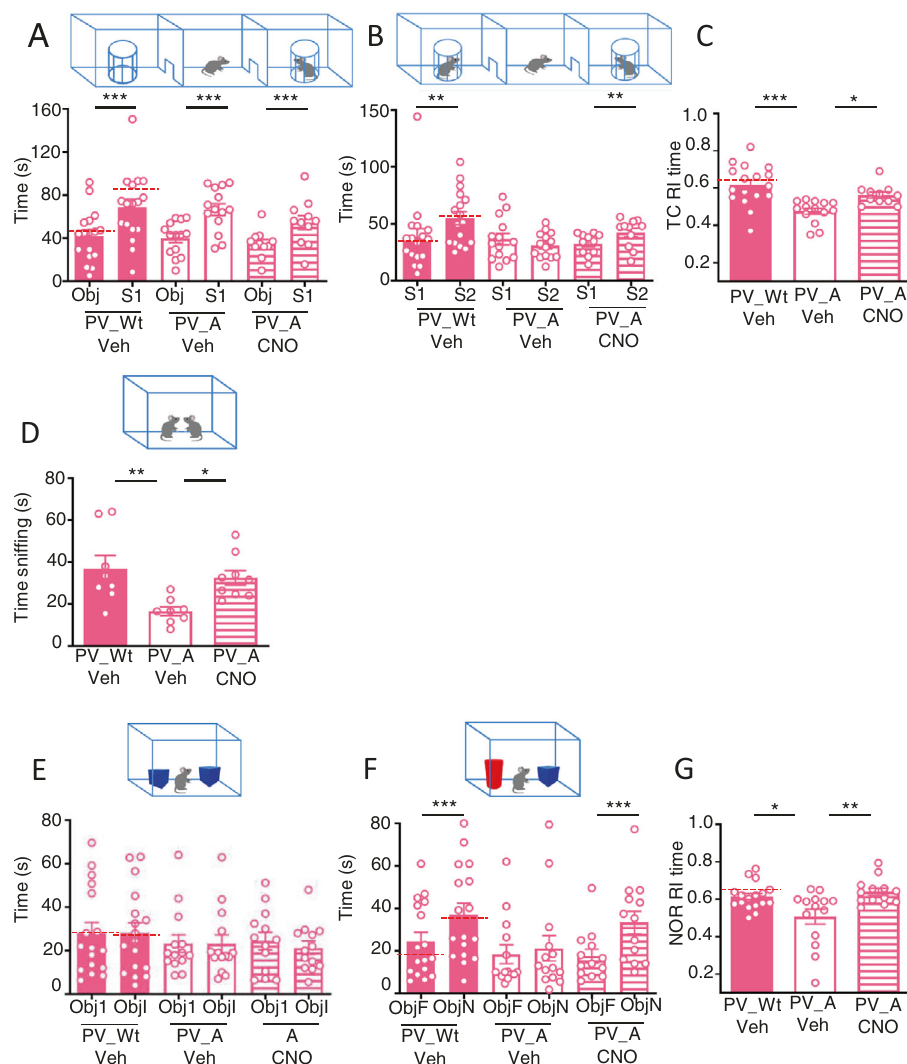
Fig. 2 Chemogenetic activation of inhibitory PV-IN in Ambra1 + / − females normalizes autistic-like behaviors. A Histogram report mean time spent exploring the object (Obj) and the conspeci fi c stranger (S1) during the sociability phase of the TC test. All mice explore more the conspeci fi c stranger than the object (PV_Wt/Veh: Obj vs S1: t (16) = 7.116, p = 0.0001; PV_A/Veh: Obj vs S1: t (13) = 7.714, p = 0.0001; PV_A/CNO: Obj vs S1: t (10) = 5.507, p = 0.0003; Dotted-line indicate mean values detected in PV_Wt/CNO control mice infused with vehicle instead of DREADDs. B Histogram report mean-time spent exploring the familiar female (S1) and the novel female (S2) during the social novelty phase of the TC test. Only PV_A/Veh females show impairment in recognition of the social novelty as they spent equal amounts of time snif fi ng S1 and S2. (PV_Wt/Veh: S1 vs S2: W = 119, p = 0.0032; PV_A/Veh: S1 vs S2: t (13) = 1.740, p = 0.1; PV_A/CNO: S1 vs S2: W = 55, p = 0.002). Dotted-line indicate mean values detected in PV_Wt/CNO control mice infused with vehicle instead of DREADDs. C Histogram reporting the mean recognition index (RI) calculated during the social novelty phase of TC. Social novelty impairments in A/Veh females are rescued in A/CNO females. TC social novelty phase: PV_Wt/Veh ( N = 17), PV_A/Veh, ( N = 14), PV_A/CNO ( N = 11), F (2,39) = 11.26 p = 0.0001; PV_Wt/Veh vs PV_A/ Veh, p = 0.00086; PV_A/Veh vs PV_A/CNO, p = 0.037. Dotted-line indicate mean values detected in PV_Wt/CNO control mice infused with vehicle instead of DREADDs. D Histogram reports mean time spent exploring an unknown conspeci fi c during the social interaction in pair test (SIP). Social interaction impairments of PV_A/Veh females in SIP test are rescued in PV_A/CNO females (SIP: PV_Wt/Veh ( N = 8), PV_A/Veh ( N = 8), PV_A/CNO ( N = 9), F (2,22) = 6.186, p = 0.007; PV_Wt/Veh vs PV_A/Veh, p = 0.009; PV_A/Veh vs PV_A/CNO, p = 0.04). E Histogram report mean time spent exploring the two identical objects (Object 1 (Obj1) and Identical Object (Obj I)) during the object exploration phase of the NOR test by PV_Wt/Veh females and PV_A females injected with Veh or CNO. Data indicate that regardless of genotype and treatment all mice similarly explore the identical objects (PV_Wt/Veh: Obj1 vs ObjI: W = 7, p = 0.88; PV_A/Veh: Obj1 vs ObjI: W = -38, p = 0.24; PV_A/CNO: Obj1 vs ObjI: t (12) = 1.102, p = 0.29). Dotted-line indicate mean values detected in PV_Wt/CNO control mice infused with vehicle instead of DREADDs. F Histogram report mean time spent exploring the familiar object (ObjF) and the novel object (Obj N) during the test phase of the NOR by PV_Wt/Veh females and PV_A females injected with Veh or CNO. Data indicate that recognition impairments of the novel object in A/Veh females are rescued in A/CNO females. (ObjF vs ObjN: PV_Wt/Veh: t (16) = 7.06, p = 0.0001; PV_A/Veh: W = -29, p = 0.38; PV_A/CNO: W = -91, p = 0.0002). Dotted-line indicate mean values detected in PV_Wt/CNO control mice infused with vehicle instead of DREADDs. G Histogram reporting the mean recognition index (RI) calculated during the test phase of NOR test. Novel object recognition impairments in PV_A/Veh females are rescued in PV_A/CNO females. (PV_Wt/Veh (N = 17), PV_A/Veh (N = 14), PV_A/CNO ( N = 13), F (2,41) = 6.59, p = 0.003; PV_Wt/Veh vs PV_A/Veh, p = 0.023; PV_A/Veh vs PV_CNO, p = 0.004). Dotted-line indicate mean values detected in PV_Wt/CNO control mice infused with vehicle instead of DREADDs. Data are expressed as mean ± s.e.m. * p < 0.05, ** p < 0.01, *** p <